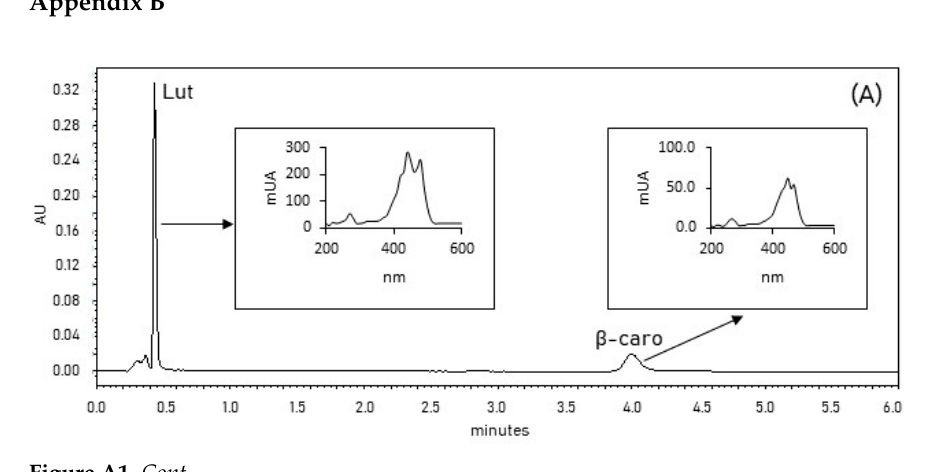
Figure A1. Chromatograms of carotenoids at 475 nm: lutein (Lut), β -carotene ( β -caro) and β -cryp- toxanthin ( β -cryp). ( A ) Standards of lutein and β -carotene. ( B ) Standard of β -cryptoxanthin. ( C ) Ex- tracted from unripe (color green) Habanero pepper grown in red soil and harvested at 334 PTD. ( D ). Extracted from ripe Habanero pepper grown in red soil and harvested at 334 PTD. Extraction method: 500 mg of Habanero pepper with 2.5 mL of ethanol was sonicated at 42 KHz for 20 min and then, centrifuged at 3500 rpm for 30 min and filtered through a 0.2 µm PTFE filters.